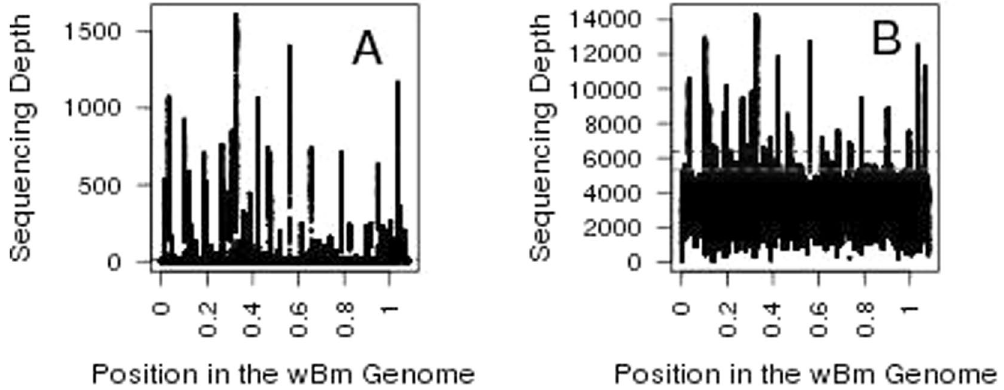
Figure 5. Sequencing Depth Across the w Bm genome. The sequencing depth is plotted for each position along the w Bm genome for the depletion data (Panel A) and the capture data (Panel B). Multi-copy nuwts are the highest peaks in sequencing depth. The thresholds for detecting sequencing depth are overlaid (16-fold cutoff for depletion data, red dotted line in Panel A, and two and three standard deviation cutoffs in the capture data, green and blue dotted lines, respectively, in Panel B). The dynamic range between the sequencing depth across multi-copy nuwts relative to the average sequencing depth across the genome is lower in the capture data than in the depletion data. Where the dynamic range is larger, as in the depletion data, it is much easier to detect nuwts, particularly lower copy number nuwts, demonstrating the utility of depleting of Wolbachia when